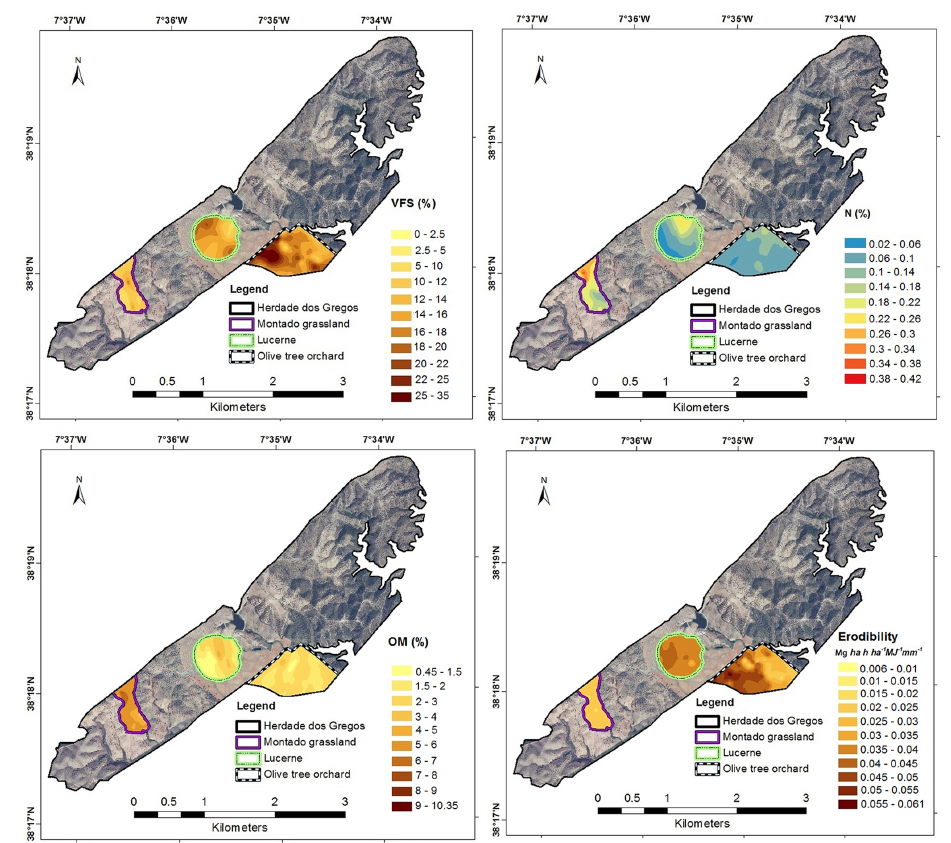
Figure 3. Prediction map of very fine sand (VFS), total nitrogen (N), organic matter (OM) and soil erodibility ( K factor).